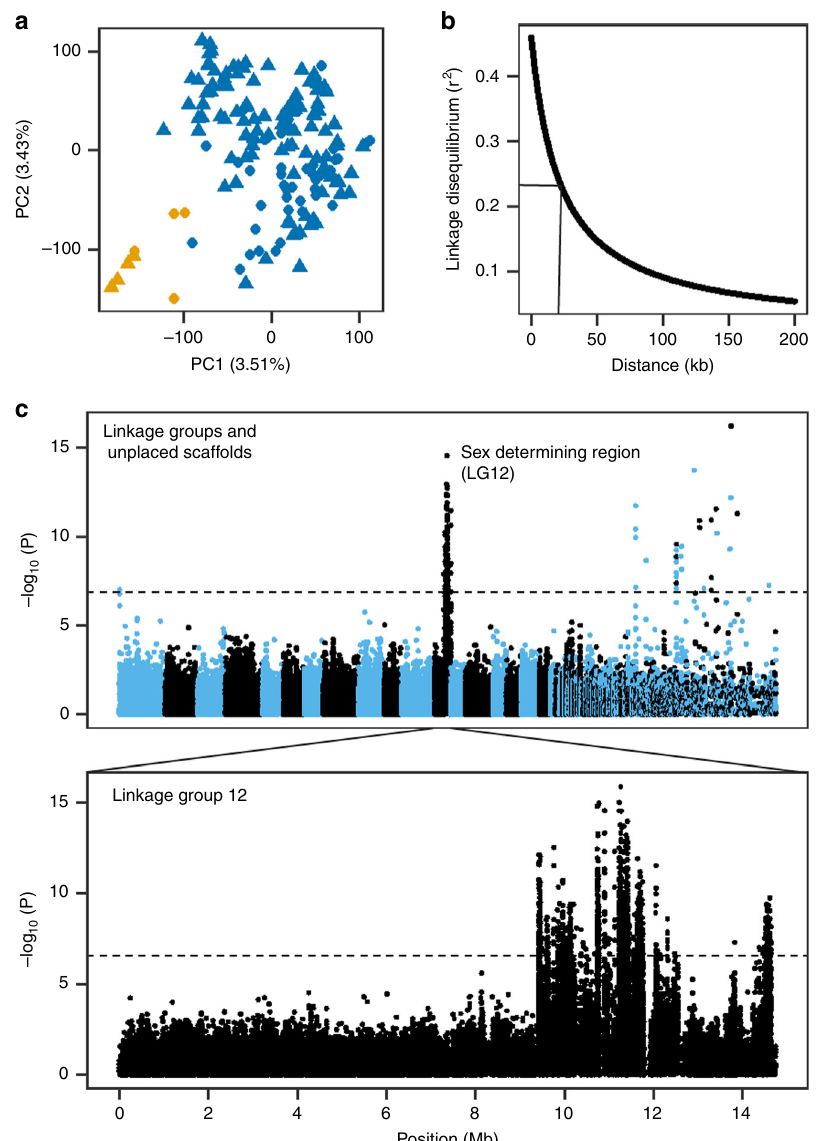
Fig. 2 GWAS analysis of the sex determination region of date palm. a PCA of genetic structure in the GWAS panel. Points are colored based on whether the ancestry of the variety traces to Middle Eastern (blue) or North African (orange) date populations. The shapes of the points indicate the location of the tree in Al-Shuwaib (triangle) or Ras Al-Khaimah (dot), b decay of linkage disequilibrium with physical distance in the GWAS mapping population. The half decay distance is 22.9 kb, c GWAS of sex determination in date palm ( n = 157 date palms). Top: Manhattan plot using the randomly downsampled SNP set (392,948 SNPs) for all linkage groups and unplaced scaffolds, below: Manhattan plot using the full SNP set on LG 12. Corresponding quantile-quantile plot can be found in Supplementary Fig. 4. Source data are provided as a Source Data fi